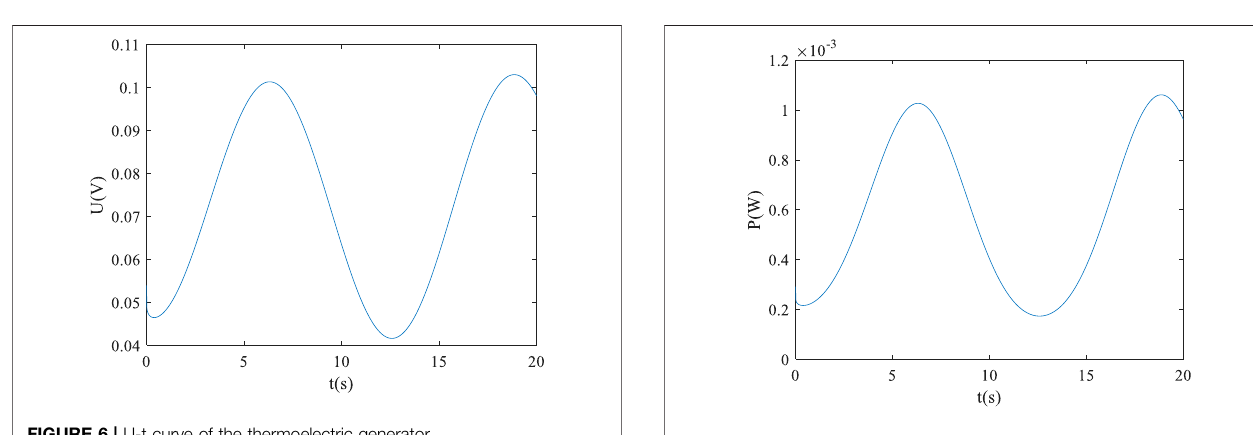
FIGURE 7 | P-t curve of the thermoelectric